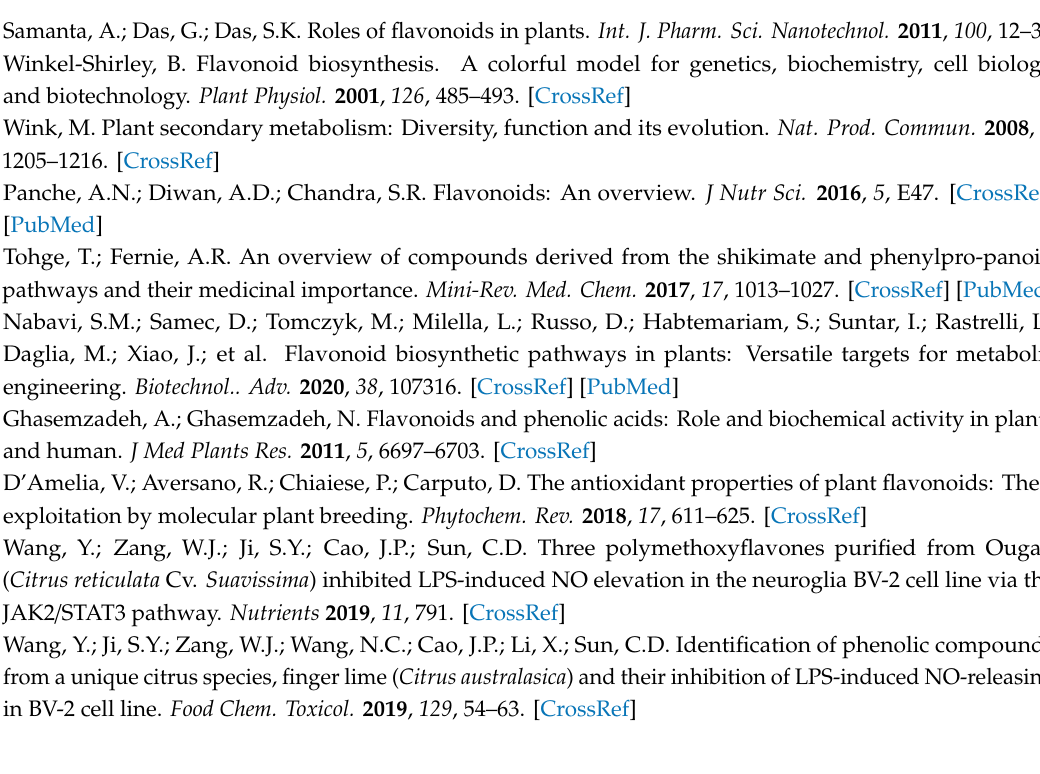
Supplementary Materials: The following are available online. Figure S1: Sequence alignment of CrOMT2 and two paralogous genes from citrus, Figure S2: biochemical characterization of the recombinant CrOMT2, Figure S3: MS / MS spectra of the authentic standards corresponding to the methylated products catalyzed by CrOMT2, Figure S4: HPLC analysis of dihydroflavonols and ca ff eic acid methylation by recombinant CrOMT2, Figure S5: Sequence alignment of CrOMT2 and other COMTs from plants, Figure S6: Cell viability after treated with flavonoids substrates or methylated products of CrOMT2 in vitro, Table S1: Percent identity of AtOMT1 against OMTs in Citrus clementina , Table S2: Primers used for amplification, Table S3: UniProt entries of COMT proteins used in the phylogenetic